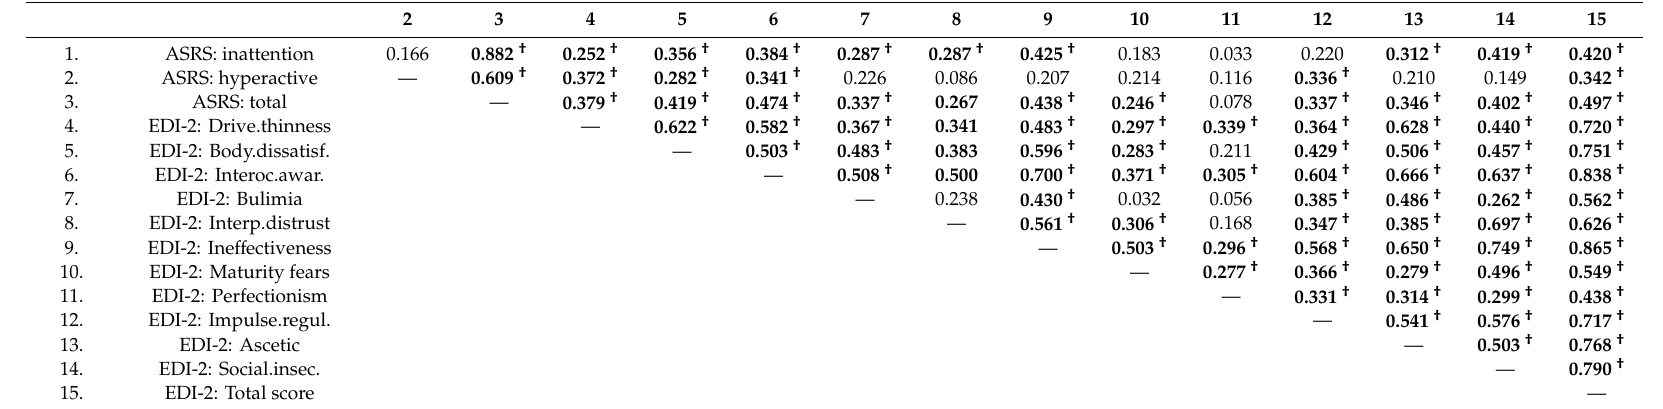
Table 2. Correlation matrix for the Adult ADHD Self-Report Scale (ASRS) and Eating Disorders Inventory (EDI-2) scores ( n =